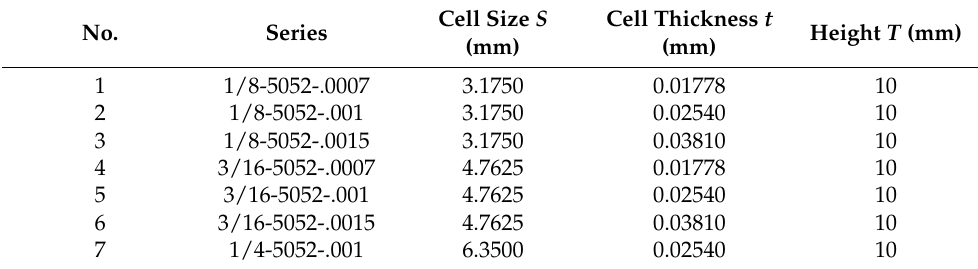
Table 1. Geometric parameters of structures intended for research.